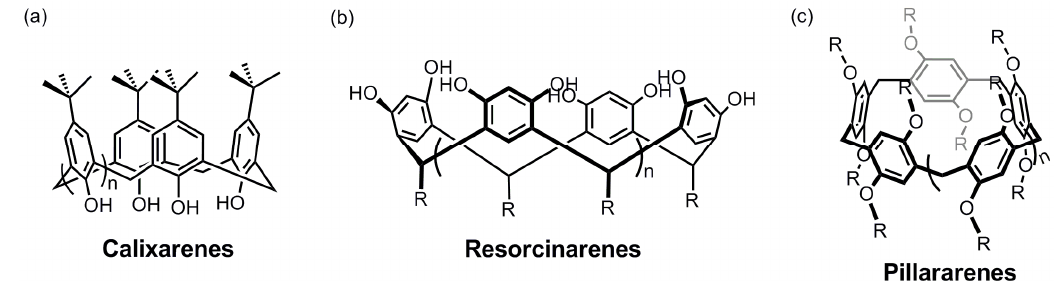
Figure 1. Chemical structures of three commonly encountered macrocyclic arenes: ( a ) calixarenes, ( b ) resorcinarenes, and ( c ) pillararenes.